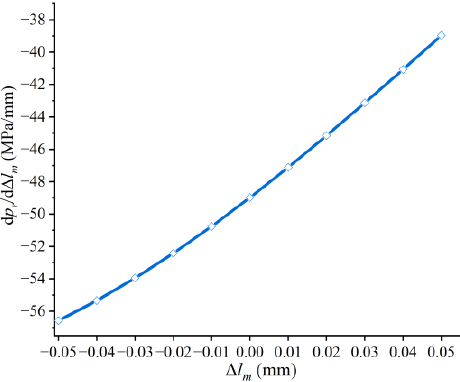
Figure 27. Balance pressure robustness against width error of shunt wedge.